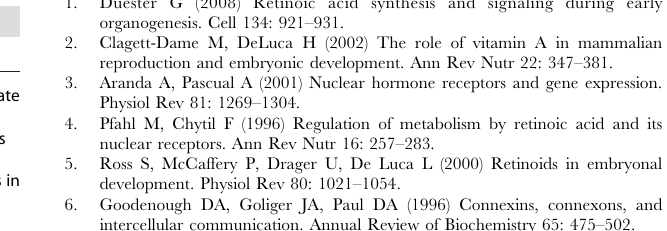
values represent Mean number of cells per dish 6 10 5 6 SE of the Mean. Values in the parentheses represent Means of % Growth 6 SE of the Mean.